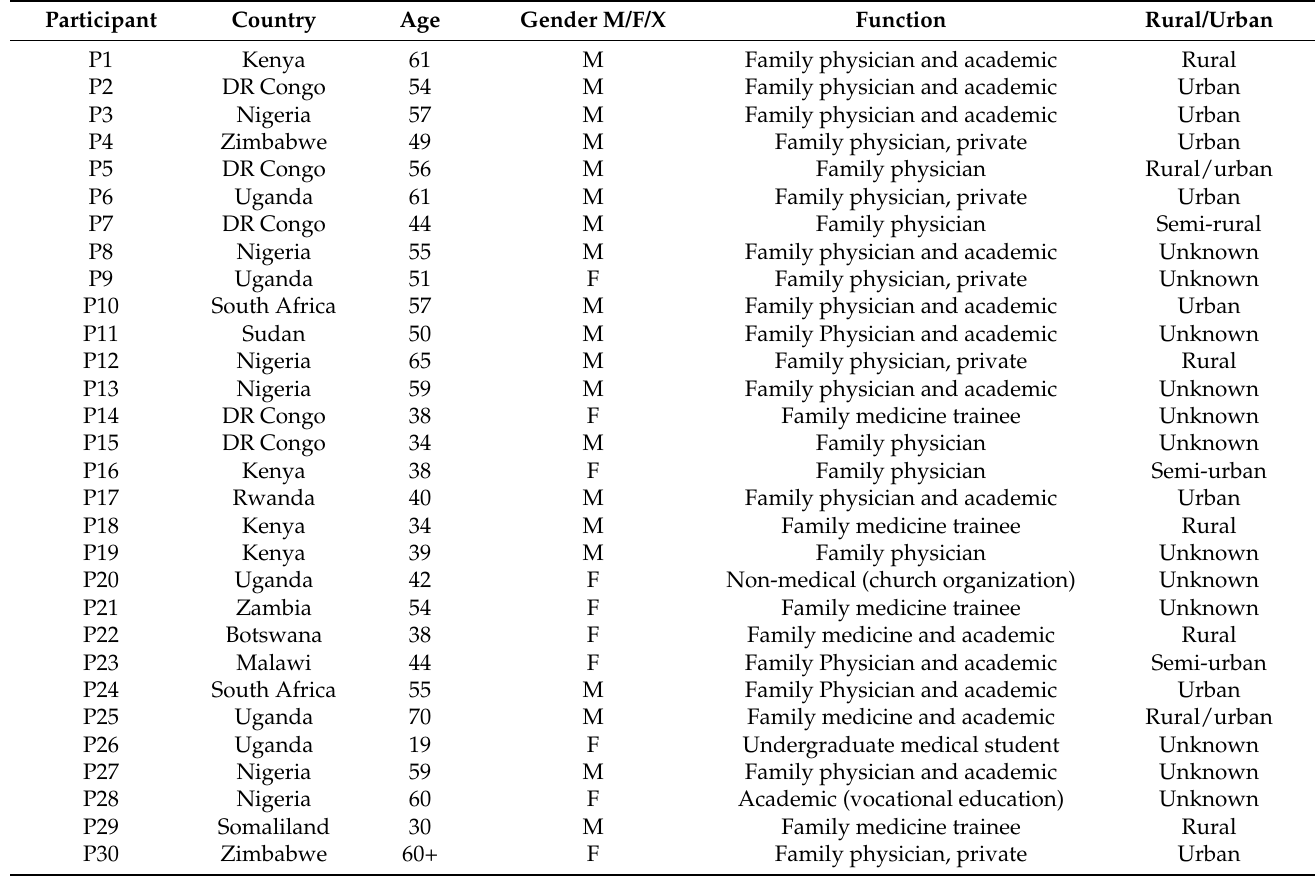
Table 1. Participants’ demographic